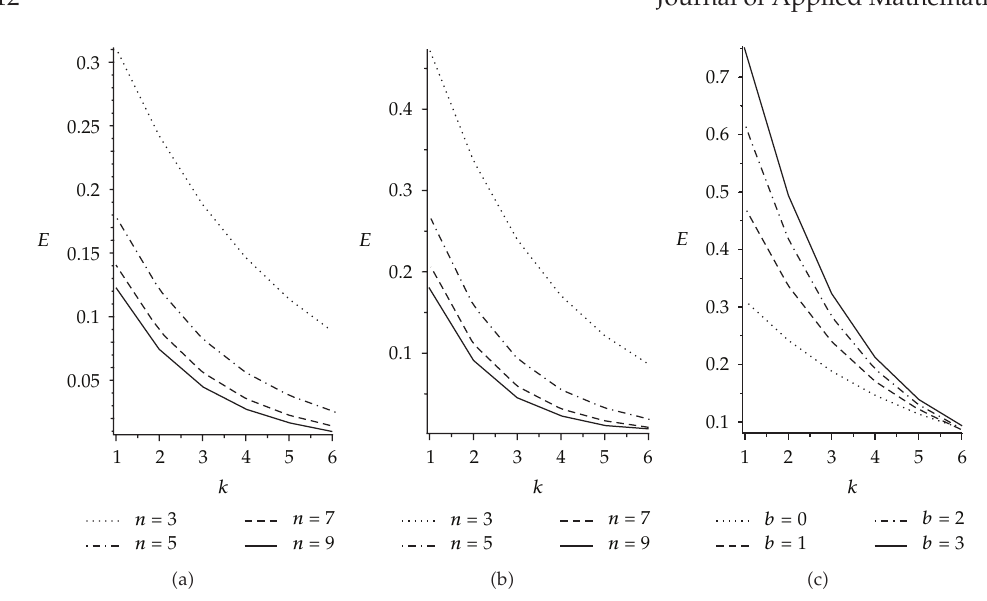
Figure 2: (cid:2) a (cid:4) Presents a comparison among error bounds of 3-point n -ary interpolating scheme, i.e., for n (cid:6) 3 , 5 , 7 , 9. (cid:2) b (cid:4) Presents a comparison among error bounds of 5-point n -ary interpolating scheme, i.e., for n (cid:6) 3 , 5 , 7 , 9. (cid:2) c (cid:4) Presents a comparison among error bounds of 2 b (cid:3) 3-point ternary interpolating scheme, i.e., for b (cid:6) 0 , 1 , 2 , 3. Here k presents subdivision level, E presents error bound and n presents arity of subdivision